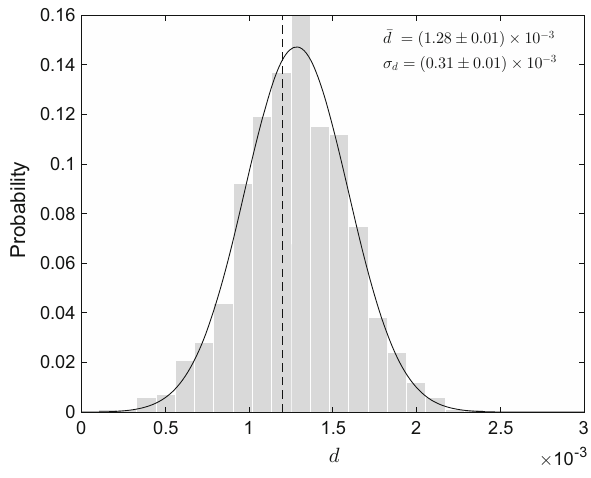
Fig. 3 The histogram of dipole amplitudes in 1000 simulations with 800 GW events ineachsimulation. The dashed lineis the fiducial dipole